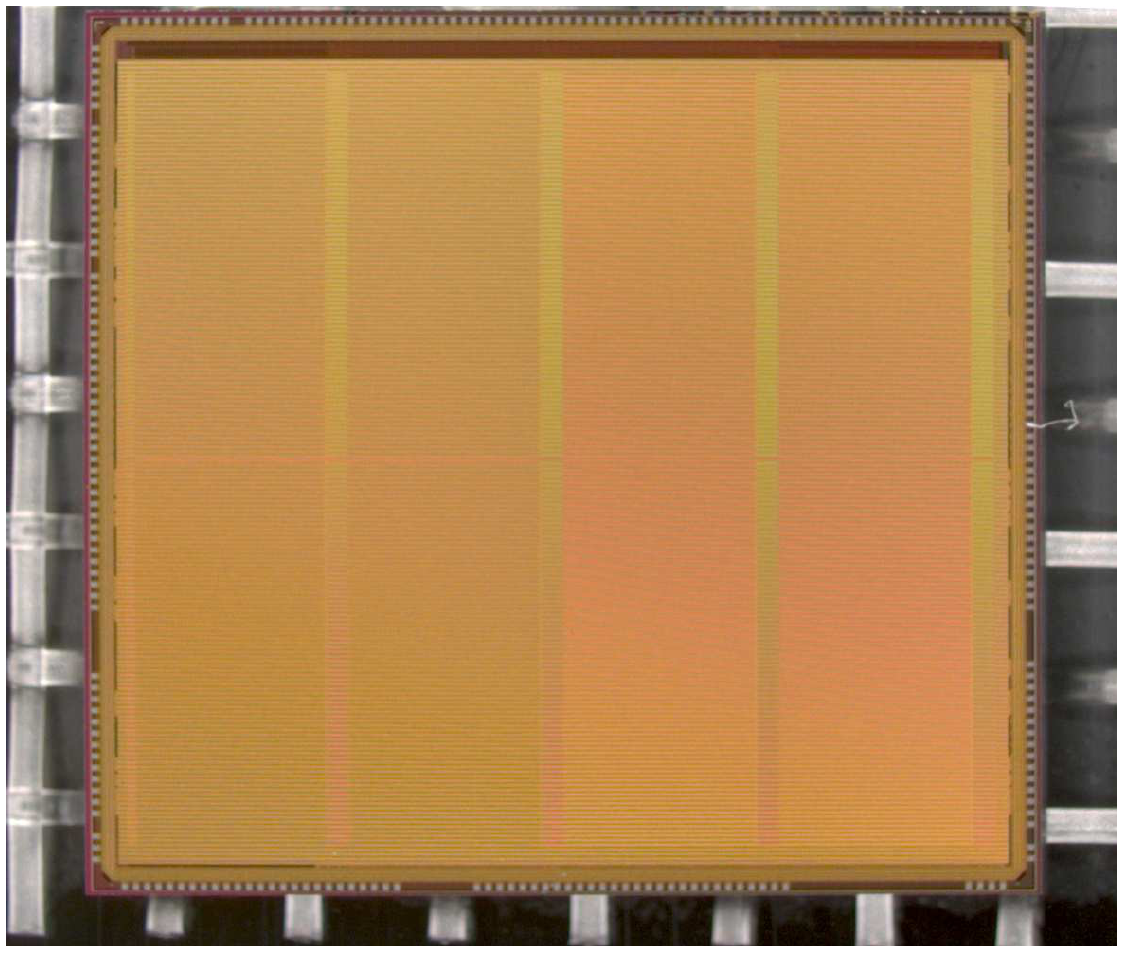
Figure 6. Photograph of the TPAC1.0